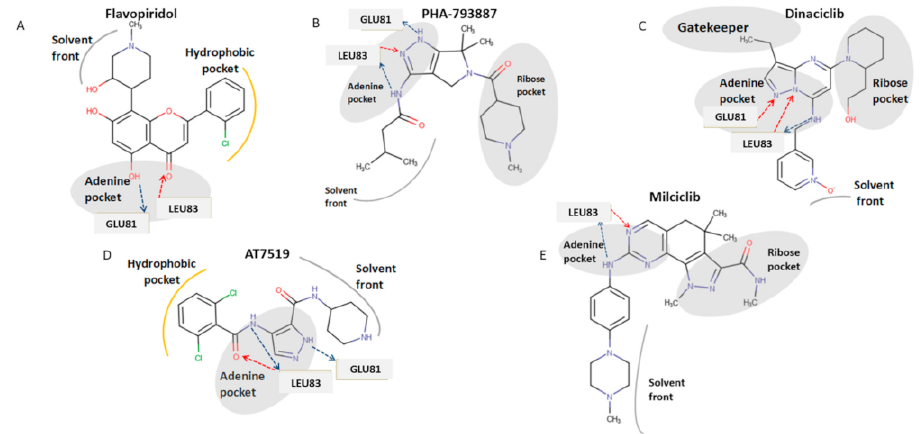
Figure 5. Structures of CDKs inhibitors and proposed binding mode of these compounds binding with CDK1. ( A ) Chemical structure of flavopiridol and its depicted binding mode with CDK1. ( B ) Chemical structure of PHA-793887 and its depicted binding mode with CDK1. ( C ) Chemical structure of Dinaciclib and its depicted binding mode with CDK1. ( D ) Chemical structure of AT7519 and its depicted binding mode with CDK1 ( E ) Chemical structure of milciclib and its depicted binding mode with CDK1. Hydrogen bonds donor interactions are indicated by blue arrows, hydrogen bonds acceptor interactions are indicated by red arrows and amino acid residues that interact with inhibitors through hydrogen bonds are shown in grey